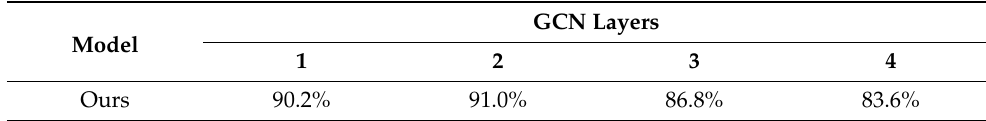
Table 4. Comparisons of overall accuracy when using a different number of GCN layers. We use the ModelNet40